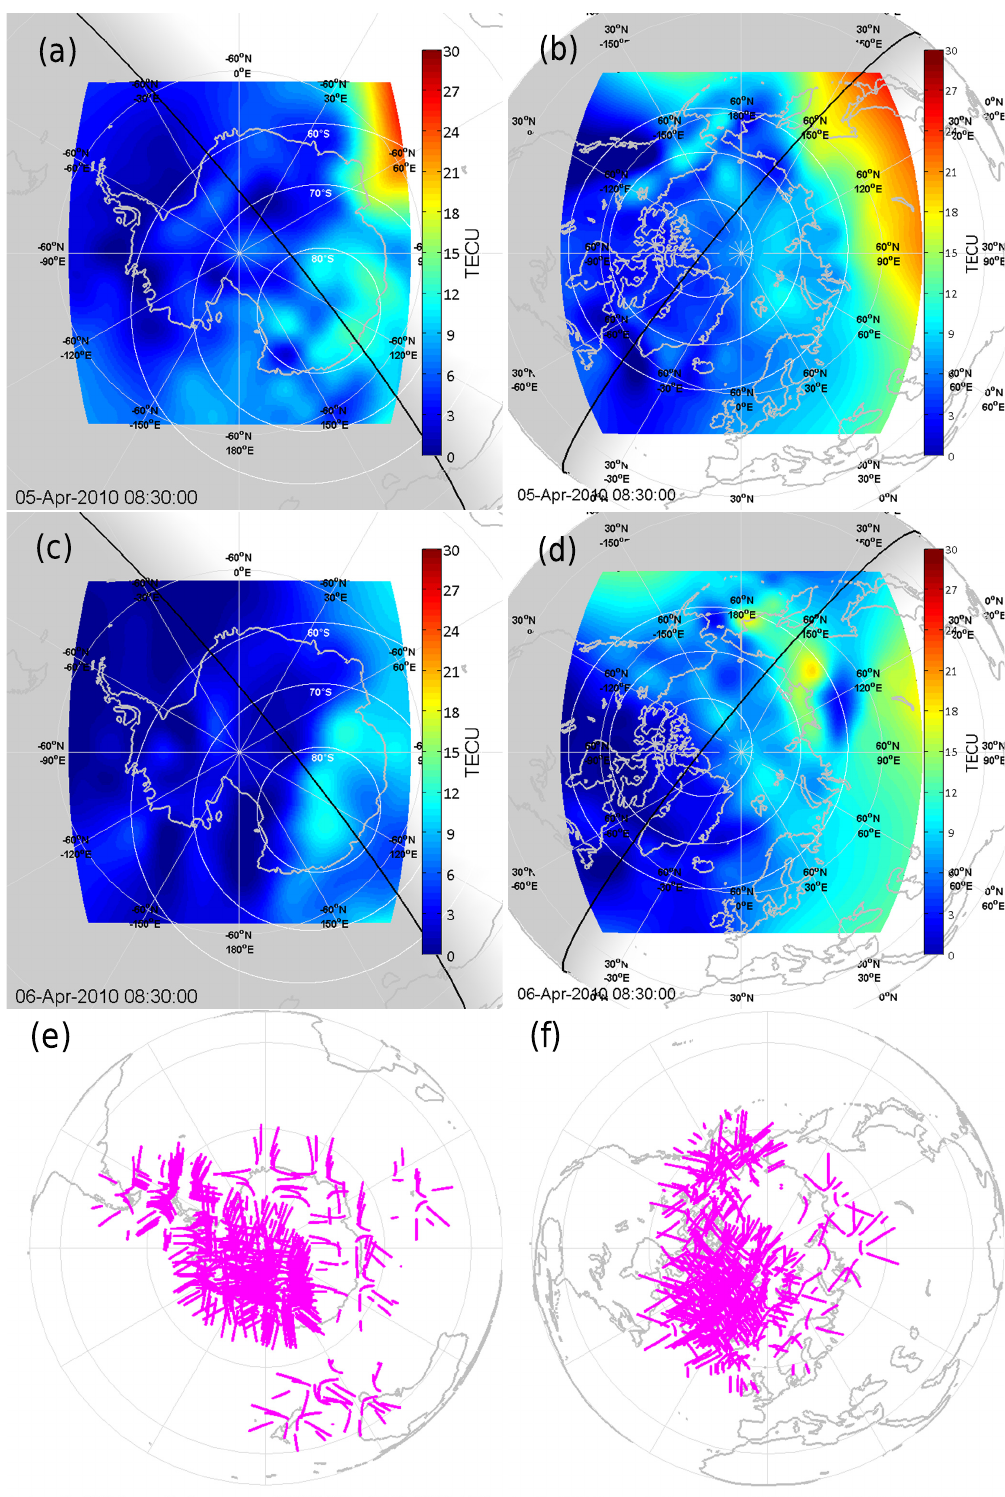
Fig. 13. (a) , (c) Southern and (b) , (d) Northern Hemisphere GPS vertical TEC maps reconstructed from 1h data centered on 08:30UT, 5 and 6 April 2010. Solar terminator (black line, ground level) and night-side shading is shown. Greenwich meridian longitude is the central vertical line in each image. Approximate geomagnetic latitude circles are centered on the 2005 AACGM pole. In Antarctica, TEC mapping used 50 sites from the PoleNet and IGS (International GNSS Service) (Kinrade et al., 2011). For the Arctic TEC maps, a total of 57 sites were used to reconstruct TEC maps. (e) , (f) The observed GPS ray path coverage was projected on to the ionosphere at an altitude of